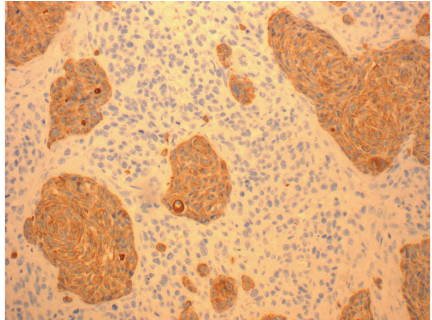
Figure4:Islandsofsquamouscellsstainingpositiveforcytokeratin. Cytokeratin AE1/3 × 100.